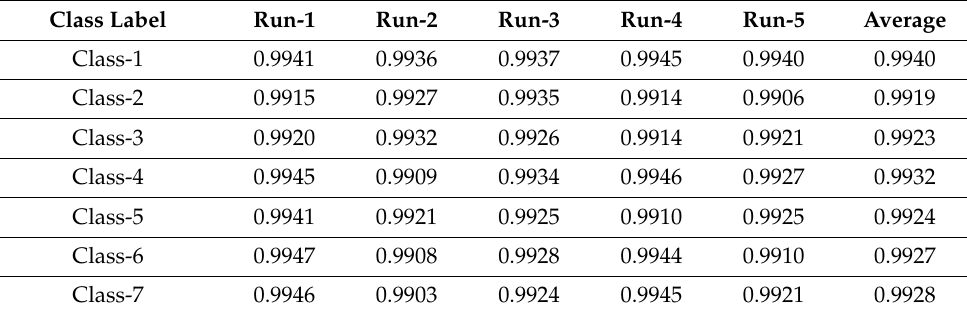
Table 2. Analytical results of the SPOAI-FD technique under Gearbox